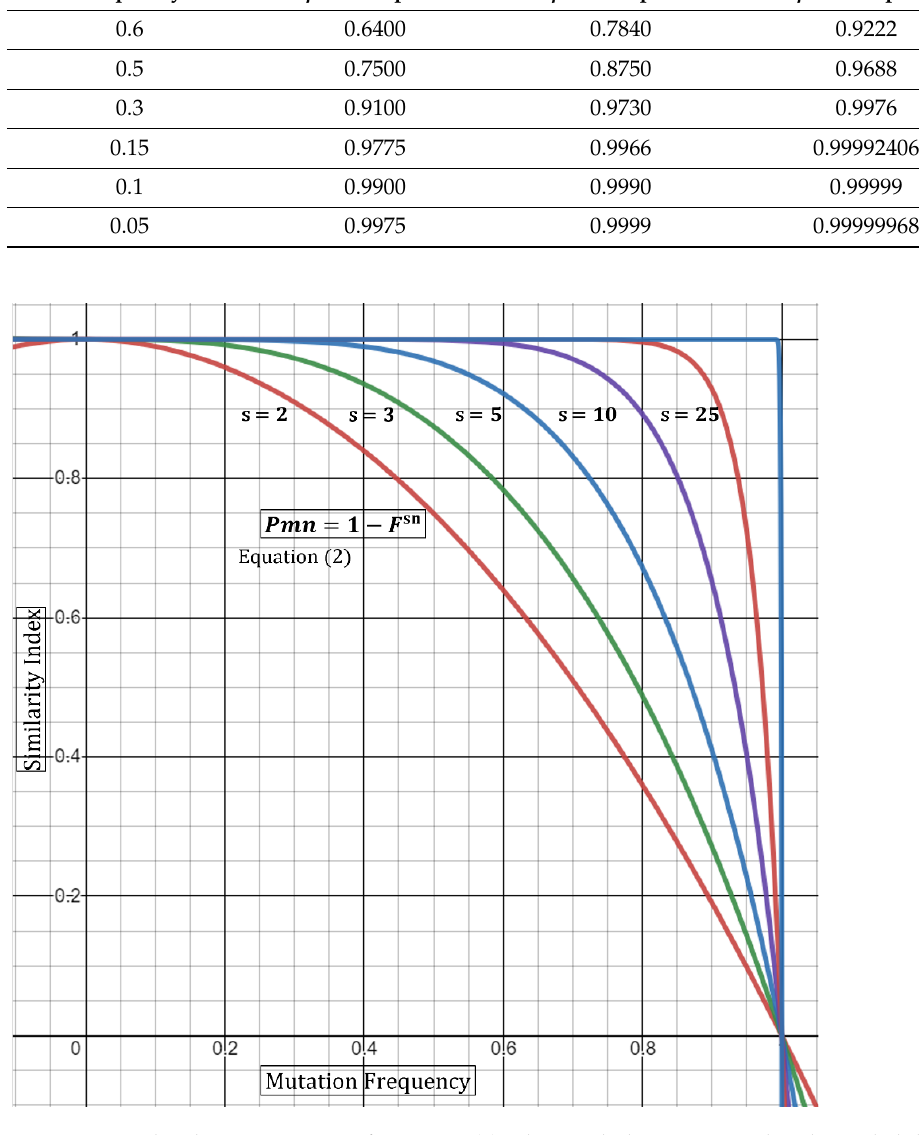
Table 1. P of non-random Association (Frequency vs. Sample Number).